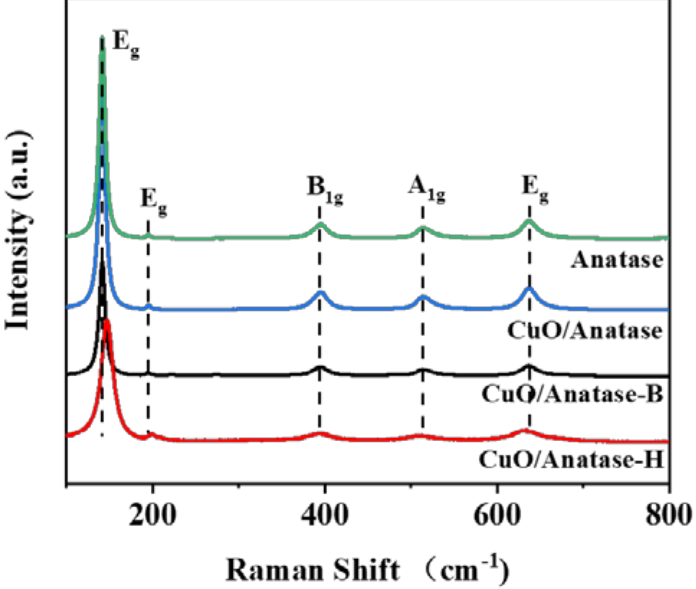
Figure 2. The Raman spectra of anatase, CuO/anatase, CuO/anatase − B and CuO/anatase − H cata- lysts.